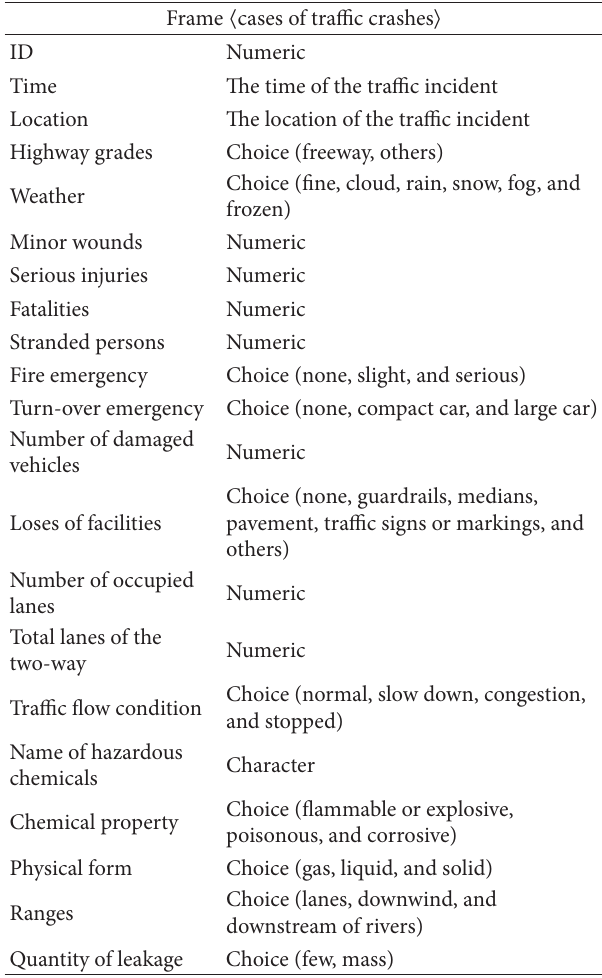
Table 1: Main frame of cases in database.